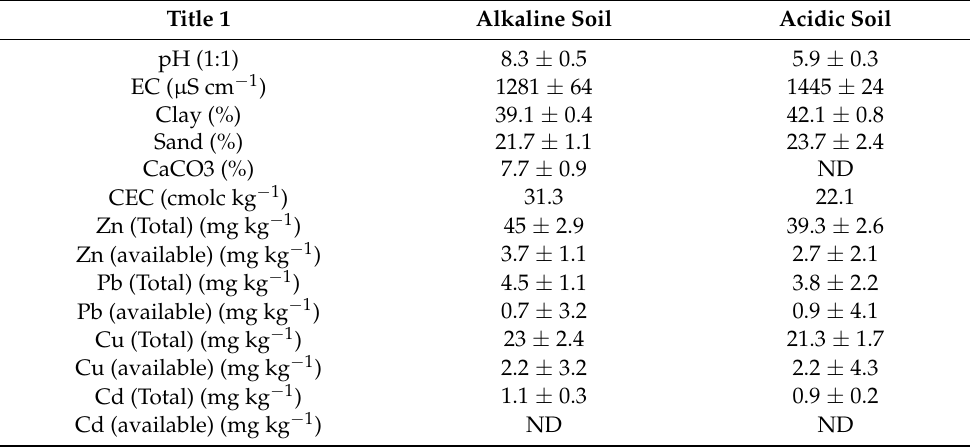
Table 1. Physicochemical parameters, total and available metal concentrations (mg kg − 1 ) of soil samples. ND: not